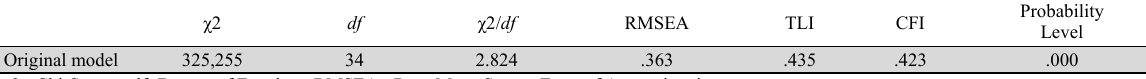
The results of Organizational Justice Scale Adaptation Indexes